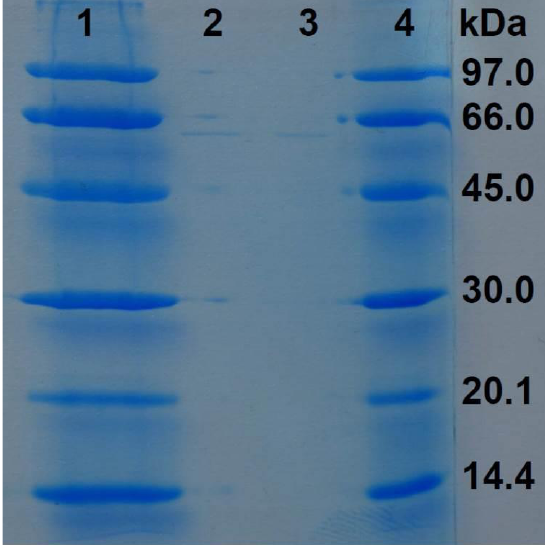
Figure 4. Detection of a peptide presents in the 45 – 60% protein precipitation fraction of the Pseudomonas fluorescens LE141 supernatant (SDS-PAGE stained with Coomassie brilliant blue; lanes 1 and 4 are the LMW marker from GE Healthcare Life Science (Uppsala, Sweden); lanes 2 and 3 are the purified peptide).